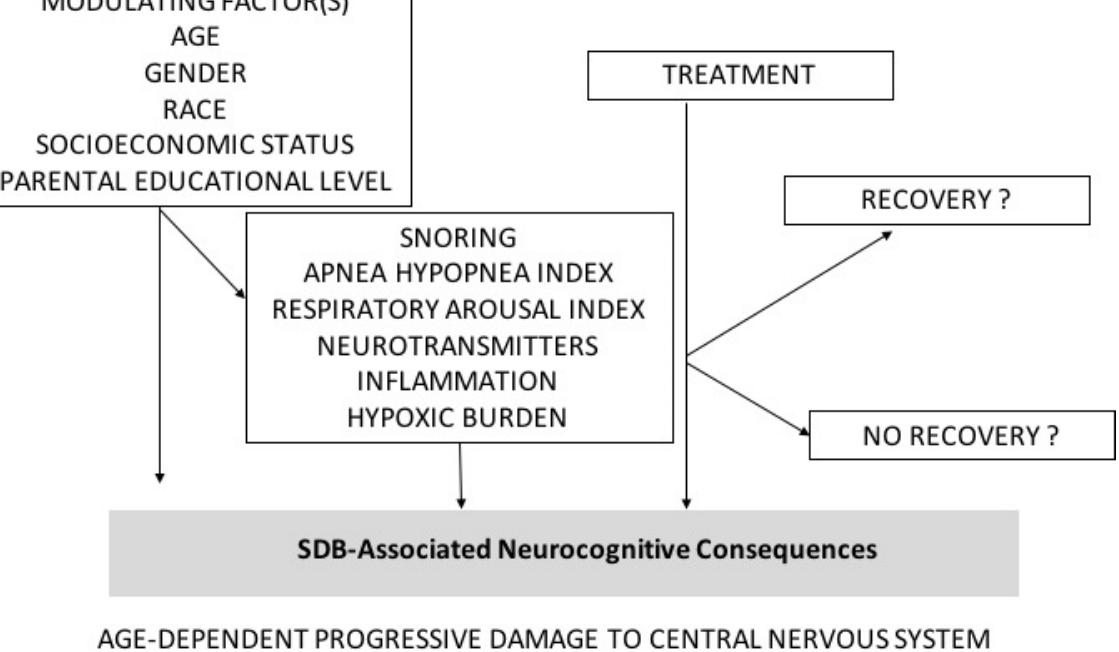
Figure 2. Modulating factors and outcomes after treatment in SDB-related neurocognitive